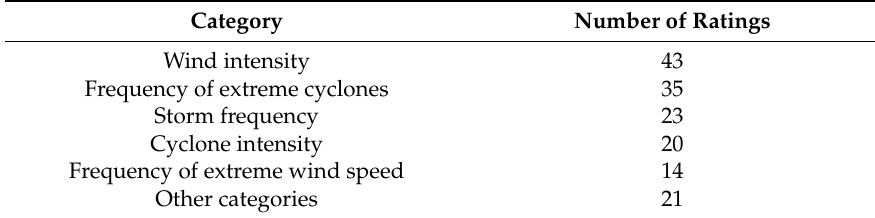
Table 9. Number of ratings assigned to categories of aspects of projected future storminess over the